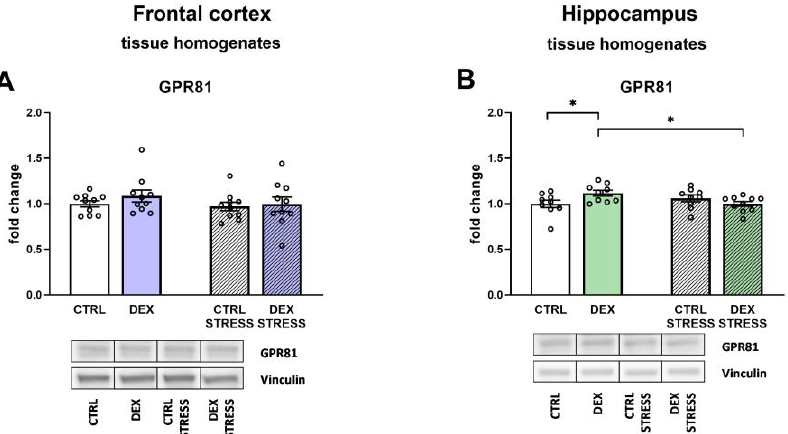
Figure 8. The effects of DEX treatment and acute stress on the levels of MCT2, MCT4, MPC1, and MPC2 in the tissue homogenates of the frontal cortex ( A , C , E , G ) and the hippocampus ( B , D , F , H ); all proteins levels were determined with Western blotting analysis; * p < 0.05, n = 8–10. The results are expressed as the average fold change ± SEM. Statistics: two-way ANOVA, followed by the Duncan test.